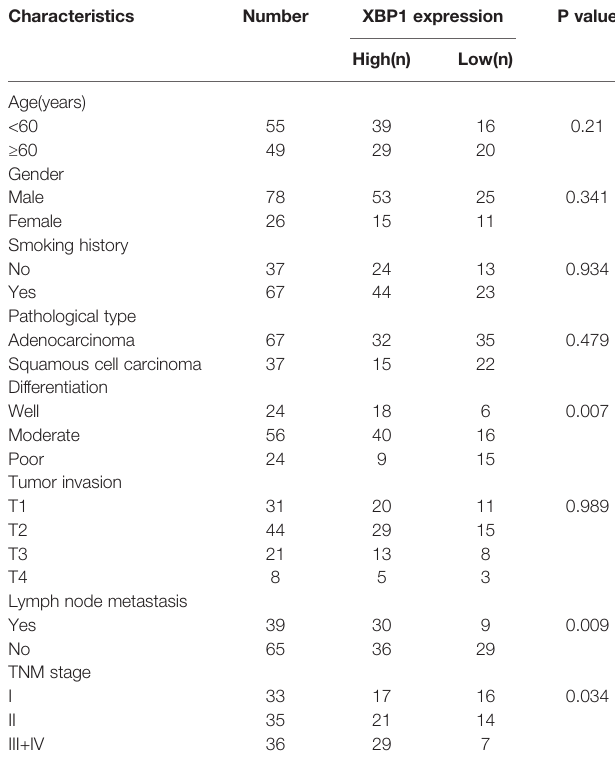
TABLE 1 | Correlation analysis of clinicopathological features between XBP1 and NSCLC patients.